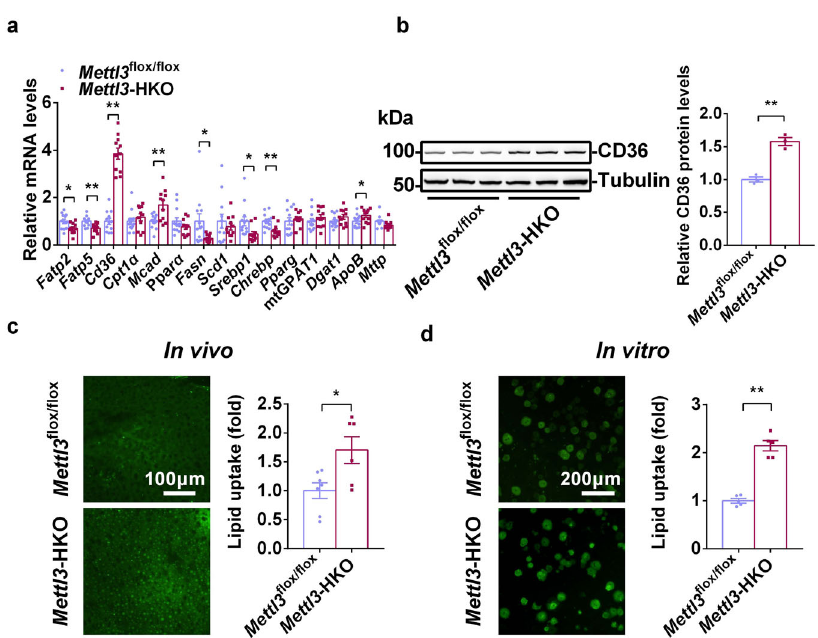
Fig. 2 Hepatic deletion of Mettl3 accelerates diet-induced NASH. a METTL3 protein levels in livers of Mettl3 fl ox/ fl ox and Mettl3- HKO mice at 8 weeks old ( n = 3 for each group; P = 0.0059). The samples were derived from the same experiment and the blots were processed in parallel. b Liver weights of Mettl3 fl ox/ fl ox and Mettl3- HKO mice at 11 weeks old ( n = 9 for each group). c Liver TAG levels in Mettl3 fl ox/ fl ox and Mettl3- HKO mice at 11 weeks old ( Mettl3 fl ox/ fl ox , n = 9; Mettl3- HKO, n = 8). d Serum ALT activity in Mettl3 fl ox/ fl ox and Mettl3- HKO mice fed an HFD for 12 weeks ( Mettl3 fl ox/ fl ox , n = 14; Mettl3- HKO, n = 13; P = 0.0332). e Liver weights of Mettl3 fl ox/ fl ox and Mettl3- HKO mice fed an HFD for 12 weeks ( Mettl3 fl ox/ fl ox , n = 8; Mettl3- HKO, n = 10; P = 0.0135). f Representative pictures and H&E staining of livers from Mettl3 fl ox/ fl ox and Mettl3- HKO mice fed an HFD for 12 weeks. g Liver TAG levels in Mettl3 fl ox/ fl ox and Mettl3- HKO mice fed an HFD for 12 weeks ( Mettl3 fl ox/ fl ox , n = 9; Mettl3- HKO, n = 11; P = 0.0007). h Serum ALT activity in Mettl3 fl ox/ fl ox and Mettl3- HKO mice fed an MCD for 3 weeks ( Mettl3 fl ox/ fl ox , n = 9; Mettl3- HKO, n = 10; P = 0.0046). i Liver weights of Mettl3 fl ox/ fl ox and Mettl3- HKO mice fed an MCD for 3 weeks ( Mettl3 fl ox/ fl ox , n = 8; Mettl3- HKO, n = 7; P = 0.0127). j Representative pictures and H&E staining of livers from Mettl3 fl ox/ fl ox and Mettl3- HKO mice fed an MCD for 3 weeks. k Liver TAG levels in Mettl3 fl ox/ fl ox and Mettl3- HKO mice fed an MCD for 3 weeks ( Mettl3 fl ox/ fl ox , n = 9; Mettl3- HKO, n = 10; P = 0.0006). l Sirius Red staining of liver sections from Mettl3 fl ox/ fl ox and Mettl3- HKO mice fed an HFD for 12 weeks ( n = 6 for each group; P = 0.0002). m F4/80 immunostaining of liver sections from Mettl3 fl ox/ fl ox and Mettl3- HKO mice fed an HFD for 12 weeks ( n = 4 for each group; P = 0.0439). n RT-qPCR analysis of mRNA levels in the livers of Mettl3 fl ox/ fl ox and Mettl3- HKO mice fed an HFD for 12 weeks ( Mettl3 fl ox/ fl ox , n = 10 – 15; Mettl3- HKO, n = 12 – 14; Collagen1A1 , P = 0.0061; α SMA , P = 0.0163; Mmp9 , P = 0.0884; Tgfb1 , P = 0.0001). o Sirius Red staining of liver sections from Mettl3 fl ox/ fl ox and Mettl3- HKO mice fed an MCD for 3 weeks ( Mettl3 fl ox/ fl ox , n = 5; Mettl3- HKO, n = 6; P = 0.00004). p F4/80 immunostaining of liver sections from Mettl3 fl ox/ fl ox and Mettl3- HKO mice fed an MCD for 3 weeks ( n = 5 for each group; P = 0.0446). q RT-qPCR analysis of mRNA levels in the livers of Mettl3 fl ox/ fl ox and Mettl3- HKO mice fed an MCD for 3 weeks ( Mettl3 fl ox/ fl ox , n = 10 – 11; Mettl3- HKO, n = 11 – 12; Collagen1A1 , P = 0.0004; α SMA , P = 0.0015; Mmp9 , P = 0.0062; Tgfb1 , P = 0.0151). n was the number of biologically independent mice. Data represent the mean ± SEM. Signi fi cance was